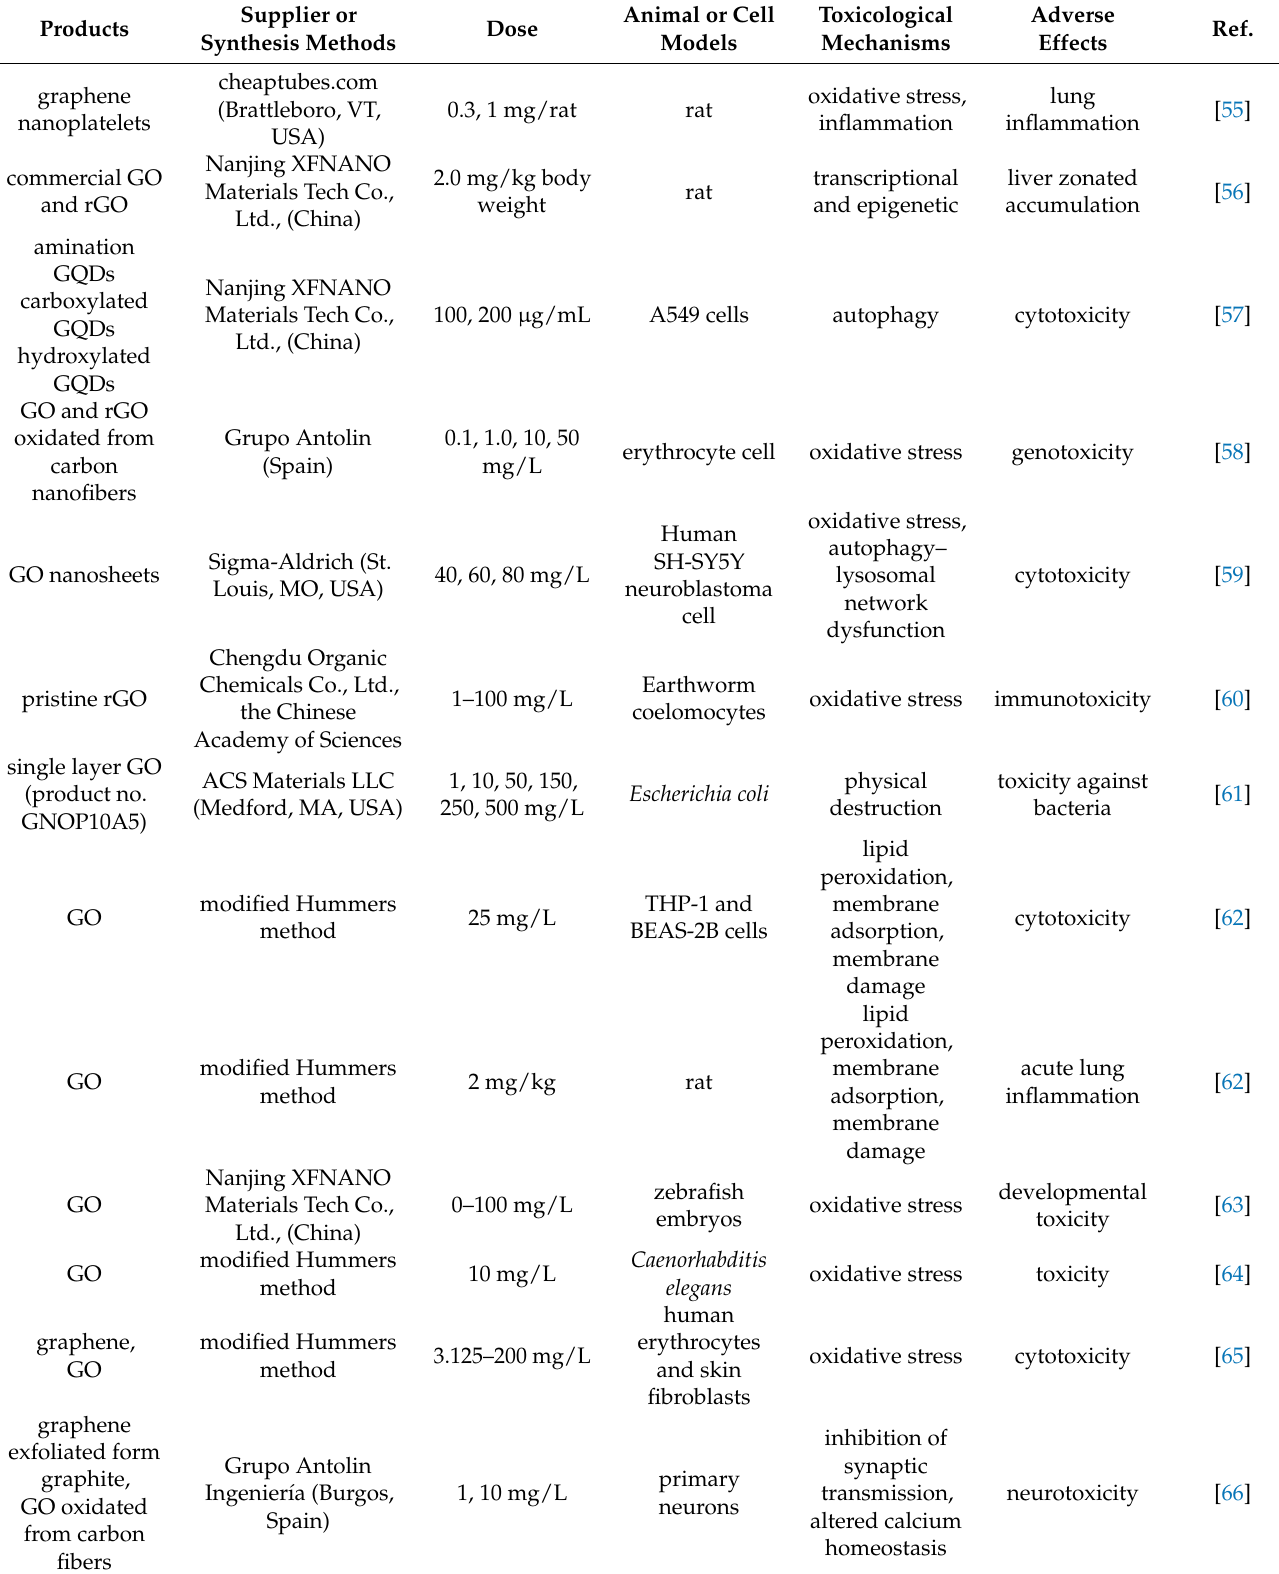
Table 1. The toxicity of GFNs in vivo and in